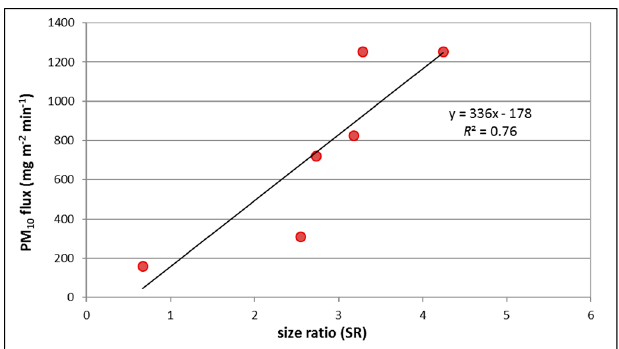
Figure 7. Correlation between aggregation (SR ratio) and PM10 flux for all the disturbed soils (Nd, Gd, Cc, Cd, Tm, To).